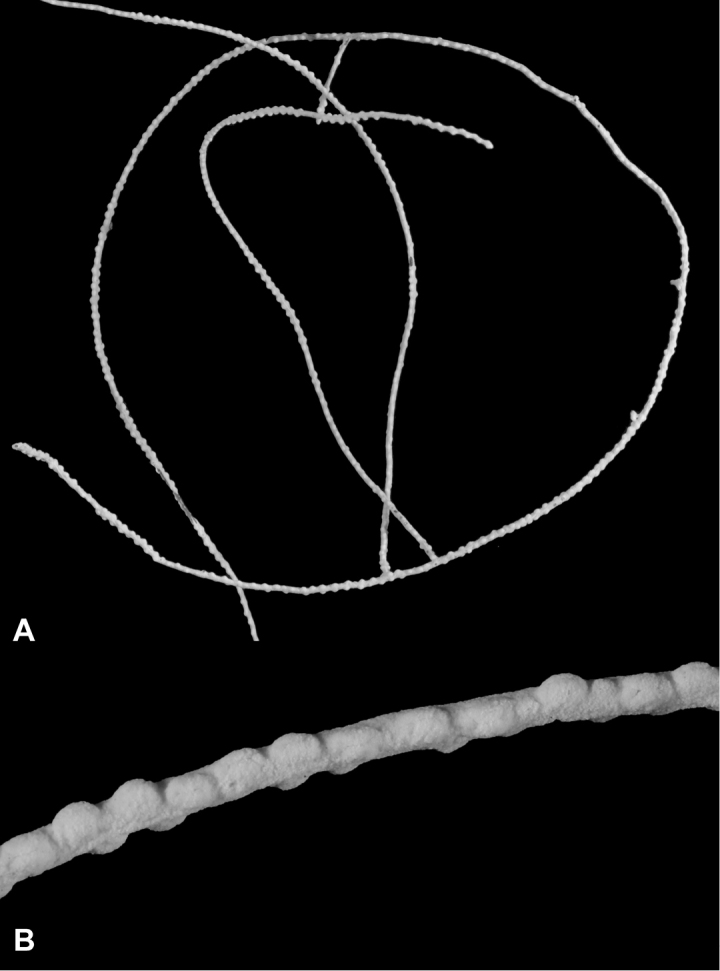
Eugorgialjubenkovia sp. nov., SBMNH 472232. A View of long, coiled specimen strands; when fully extended, longest strand length ~37 cm. Strand diameter (excluding polyp mound) ~1.0 mm B Magnification of branch strand, showing small, rounded polyp mounds.